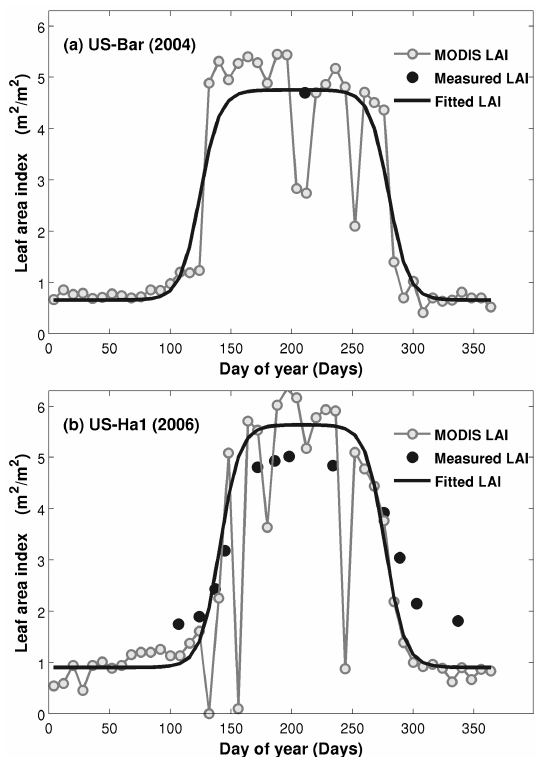
Figure 8. Comparisons of field-measured and satellite-derived LAIs for the sites (a) US-Bar in 2004 and (b) US-Ha1 in 2006. The solid grey lines denote MODIS LAI as obtained from standard MODIS FPAR/LAI products (MOD15A2). The solid black lines denote dou- ble logistic fitting lines that are applied to MODIS LAI. The solid points denote the measured LAI as obtained from biological data sets from the AmeriFlux